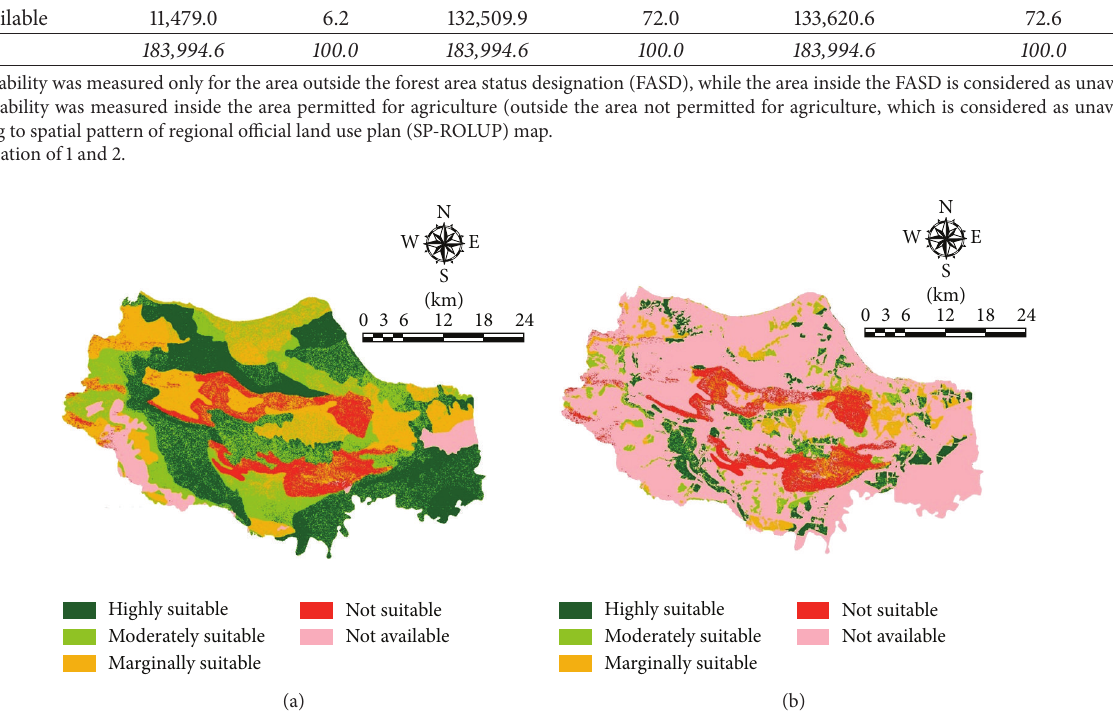
Figure 6: Land in Tuban Regency which is both suitable and available for agriculture, taking into account (a) FASD and (b) SP-ROLUP.